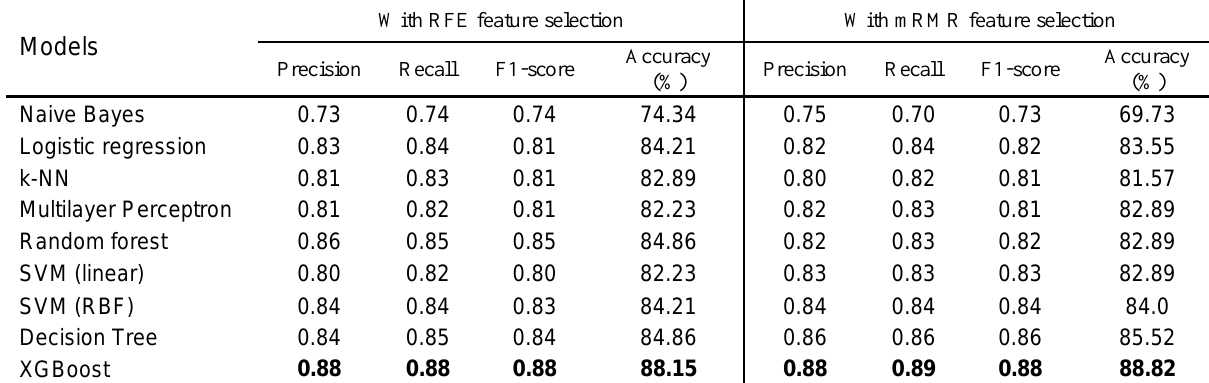
Table 1. All feature subsets except TQWT using RFE and mRMR.